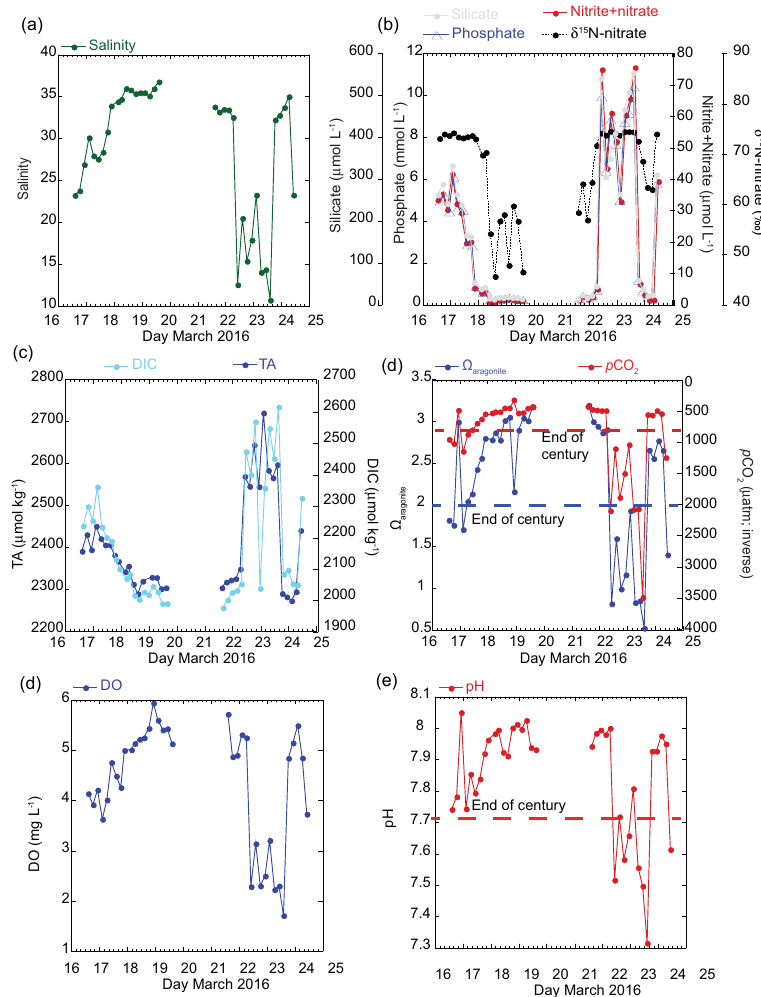
Figure 2. Results of time series of seawater chemistry variables over a 6-day period collected from the vent site located on the nearshore reef every 4h. (a) Salinity, (b) dissolved nutrient (nitrate plus nitrite, phosphate, and silicate) concentrations (µmolL − 1 ) , and nitrate stable nitrogen isotopes ( δ 15 N-nitrate; ‰), (c) total alkalinity (TA) and dissolved inorganic carbon (DIC) (µmolkg − 1 ), (d) calculated carbonate parameters for aragonite saturation state ( (cid:127) arag ) , and p CO 2 (µatm; inverted) based on DIC–pH pairwise and measured salinity, temperature, nutrient (phosphate and silicate) data, (e) dissolved oxygen (DO; mgL − 1 ) , and (f) temperature-corrected pH (total scale). End-of-century projections are according to IPCC-AR5 RCP8.5 “business as usual” scenario for pH (reduction by 0.4 units), (cid:127) arag (2.0; blue dashed), and p CO 2 (750µatm; red